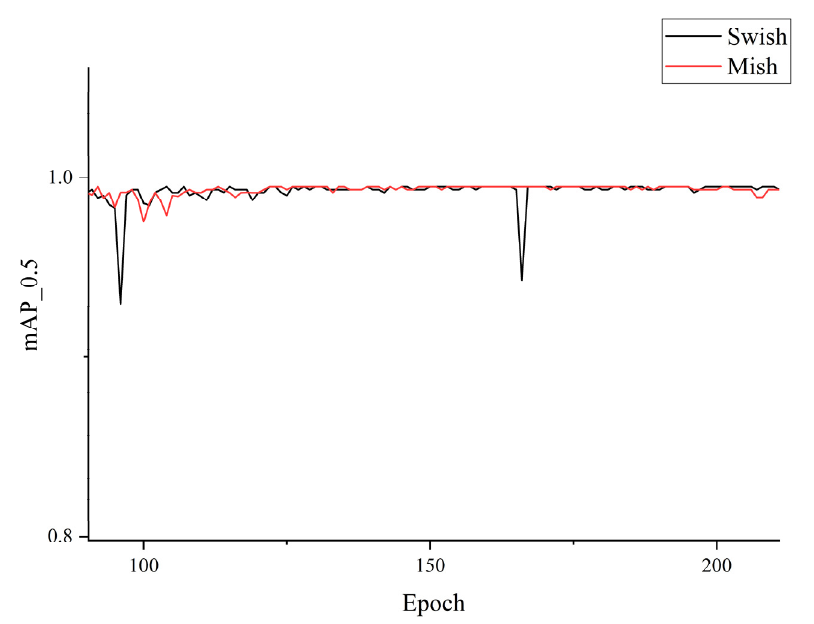
Figure 7. Comparison of the Mish and Swish activation function on the SSDD dataset with a zoomed-in display.